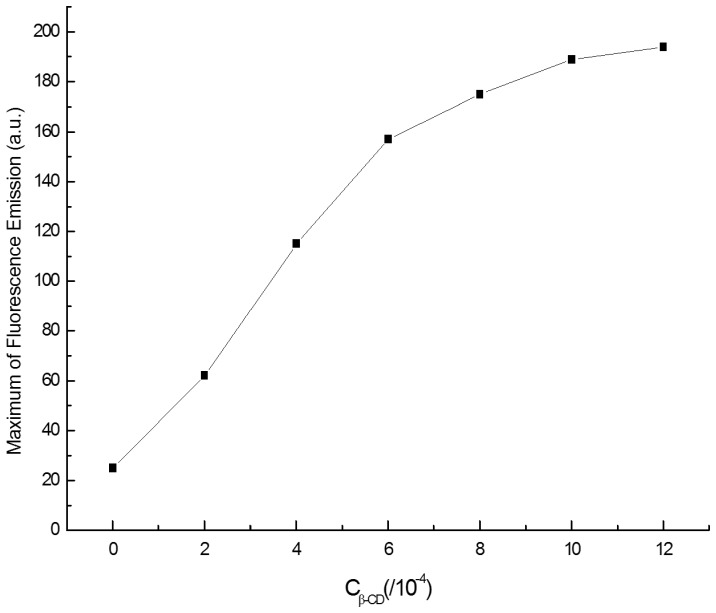
Effect of the β -CD concentration.Cberberine hydrochloride = 2.00 µg/mL, pH = 9.00.